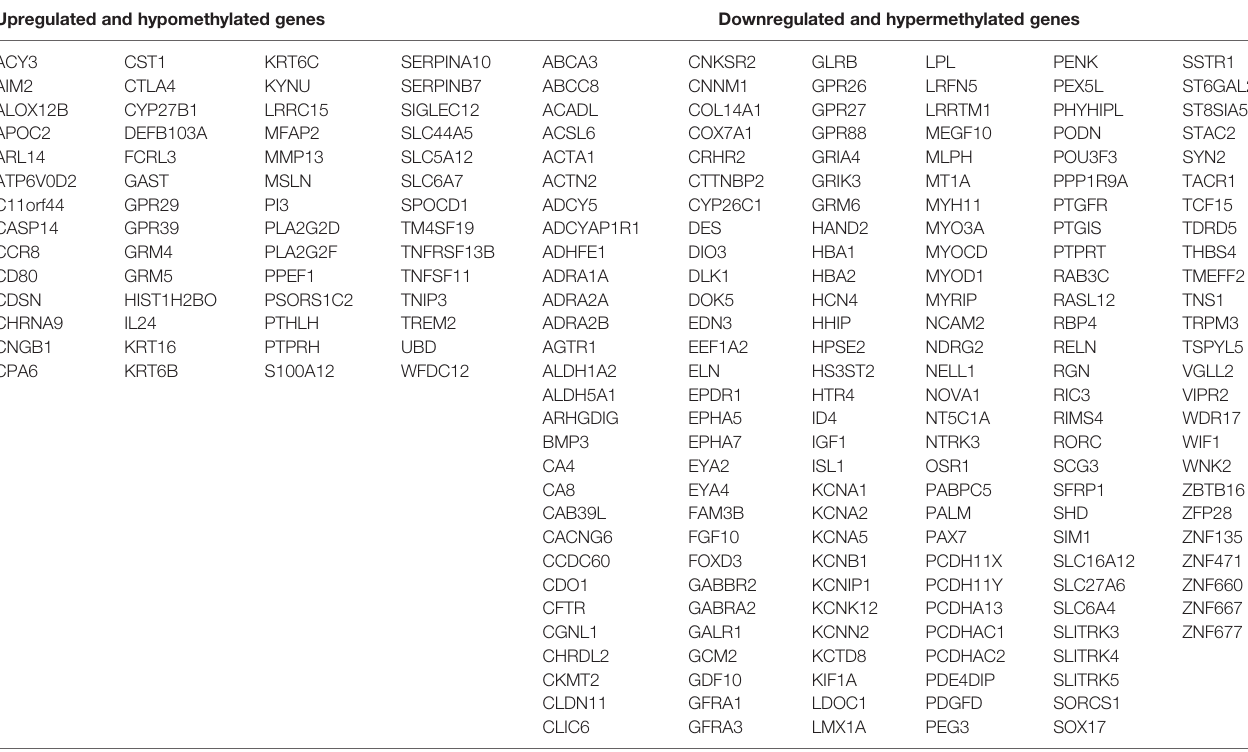
TABLE 3 | Methylation − regulated differentially expressed genes. Upregulated and hypomethylated